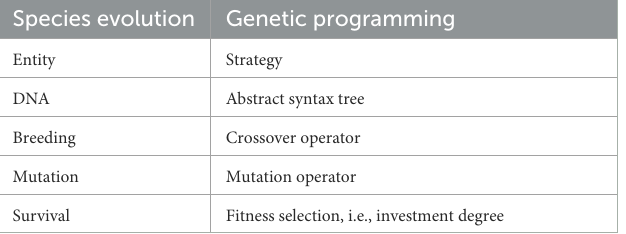
FIGURE6 Operators and terminals.